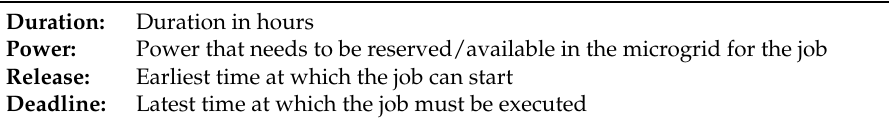
Table 1. Properties of jobs used in the scheduling